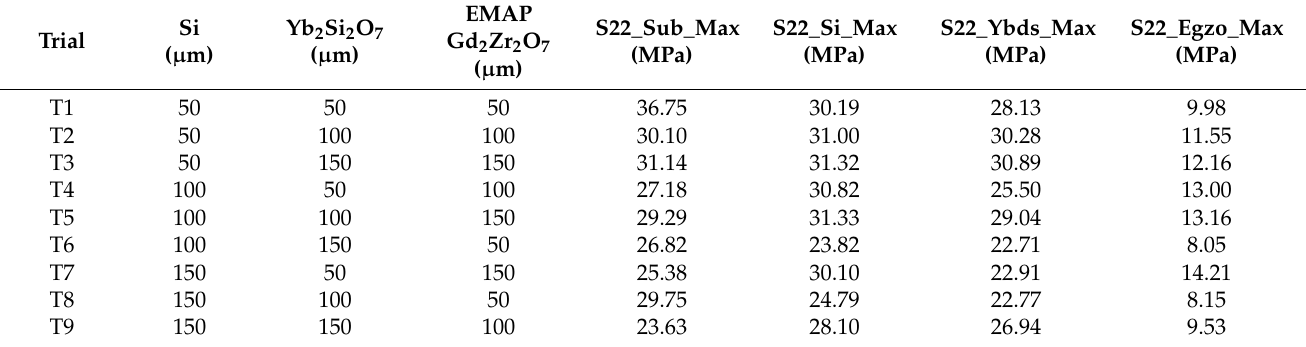
Table 3. Values of S22_Max in each region of EGYS coating system in orthogonal